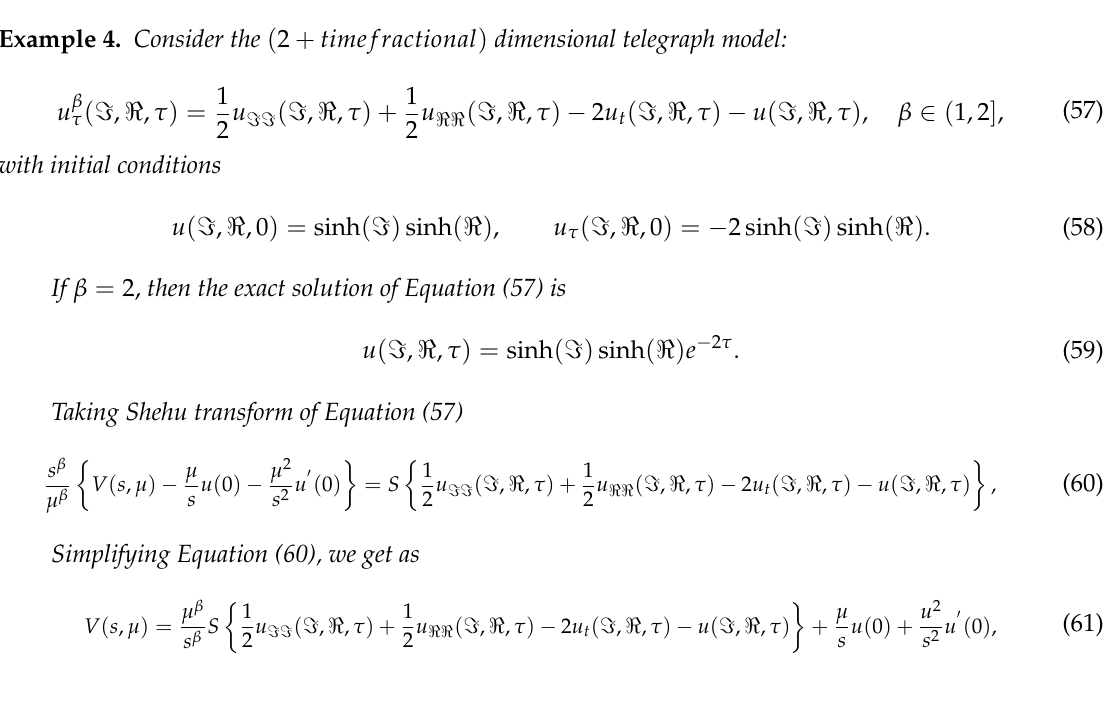
Figure 11. The solution graph at different fractional order β